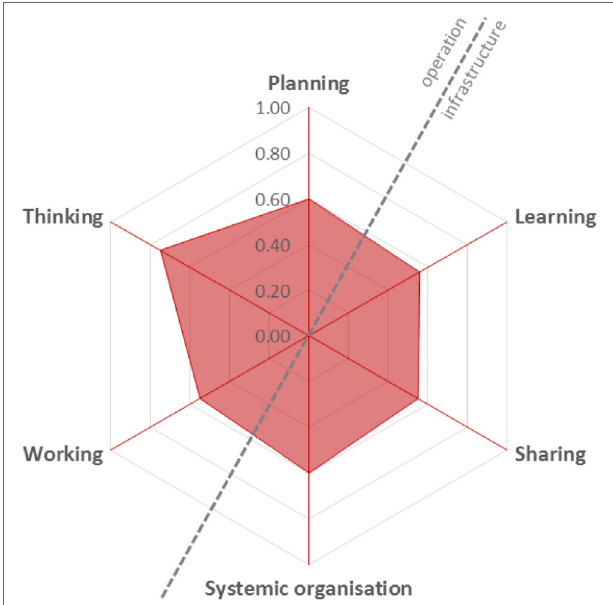
Figure 3 | Spider diagram showing the One Health (OH) Index scores assigned for the different elements of the One Health-ness evaluation. The overall OH Index calculated from the area enclosed (shown in red) = 0.34. The hexagon is made up from the scores allocated to the OH operations (thinking = 0.63, planning = 0.60, working = 0.60) and OH infrastructures (learning = 0.55, sharing = 0.50, systematic organization = 0.60). The scores were compared to the ideal scenario (score 1.0). The One Health Ratio is calculated as a comparison of operational scores against infrastructure scores and is 1.20.